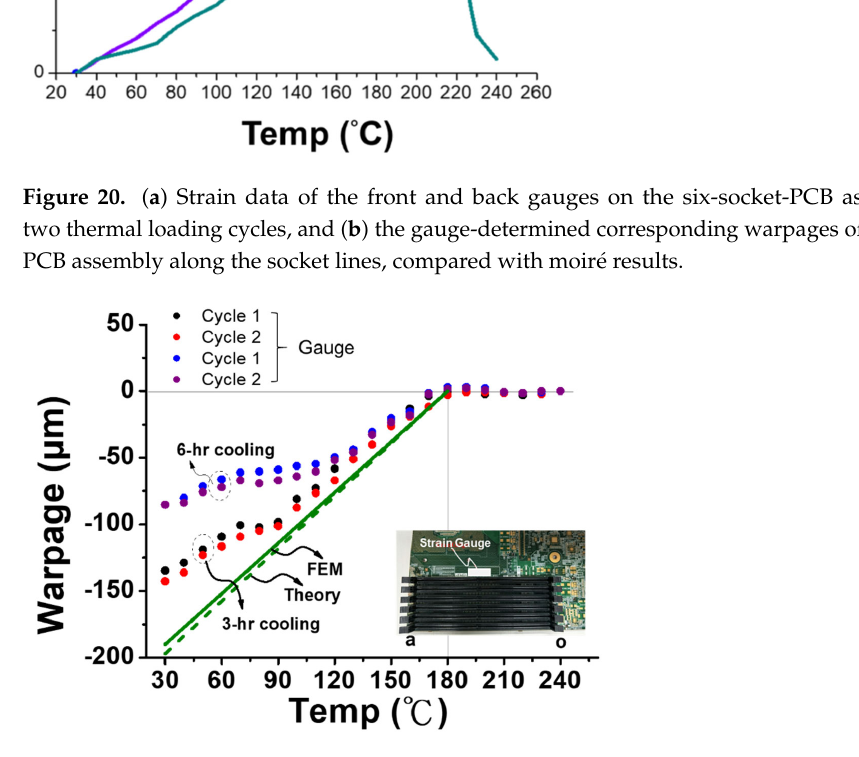
Figure 21. The cooling rate effect on thermally induced warpages of the six-socket-PCB assembly along the socket lines after solder reflow, from strain gauge, theory, and FEM simulation.